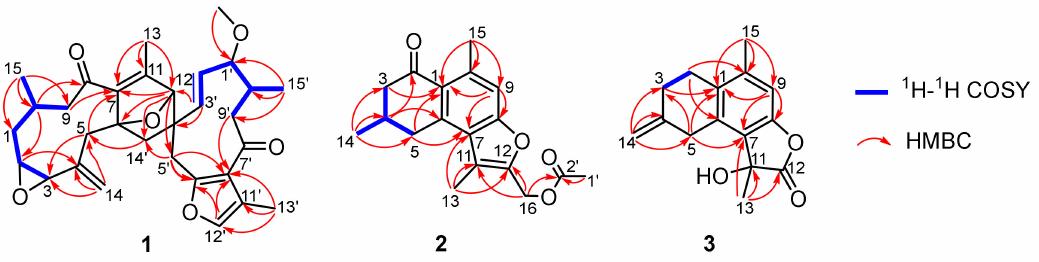
Figure 2. Key 1 H- 1 H COSY and HMBC correlations for ( 1 – 3